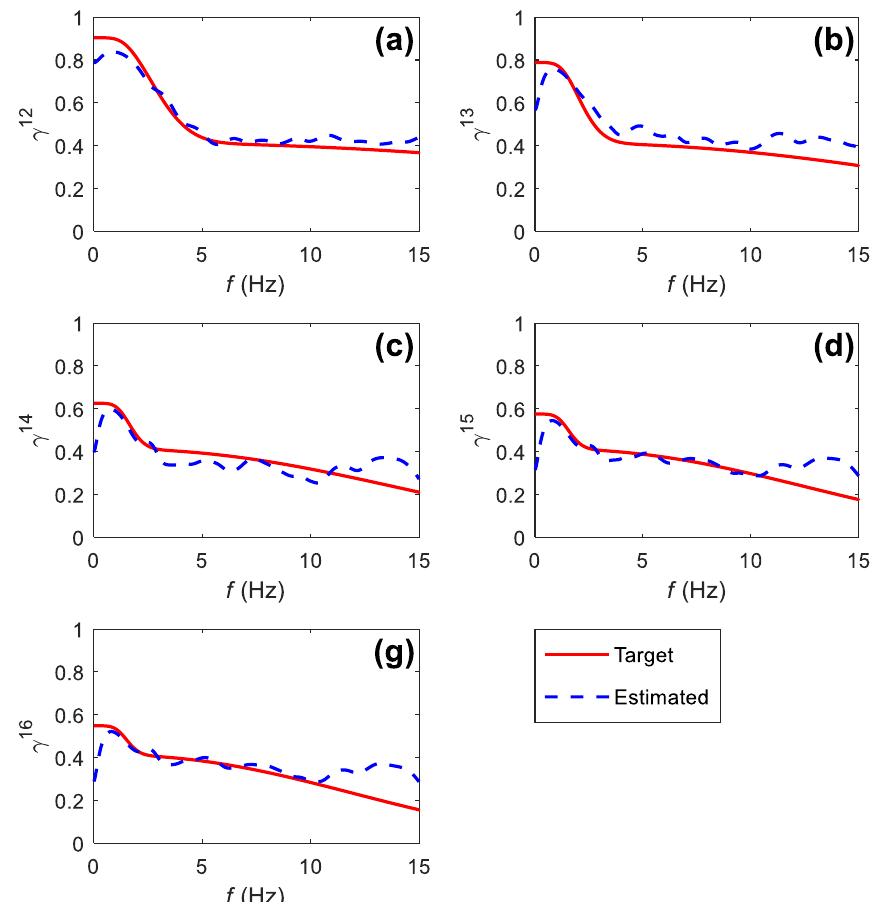
Fig. 14 Comparison between the estimated and target coherences in the Jiuzhou bridge case: a Coherence γ 12 with d 85 m, b Coherence γ 13 with d = d 608 m, and e Coherence γ 16 with d =